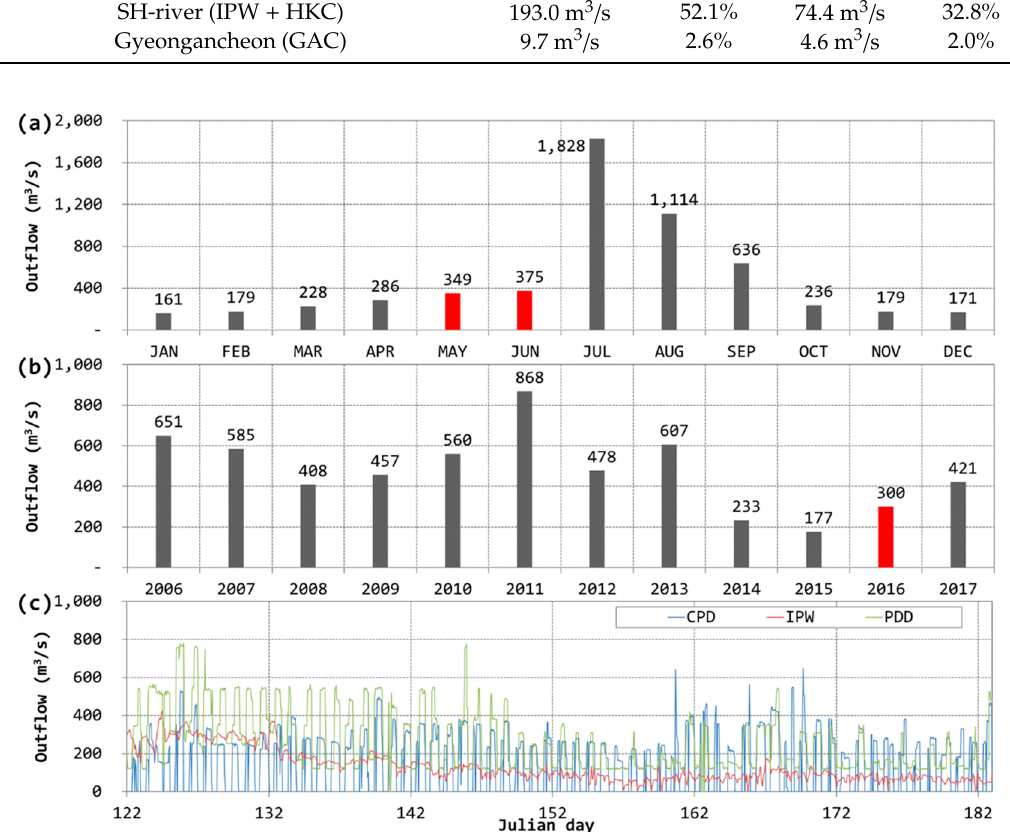
Figure 2. Discharge trend of Paldang Dam over the past 10 years. ( a ) average monthly outflow for 2006–2016; ( b ) average annual outflow for 2006–2016; and ( c ) hourly variations of discharge for Paldang Dam (PDD), Cheongpyeong Dam (CPD), and Ipo Weir (IPW) from Julian day 122 to 152 (May 2016) and 153 to 182 (June 2016).